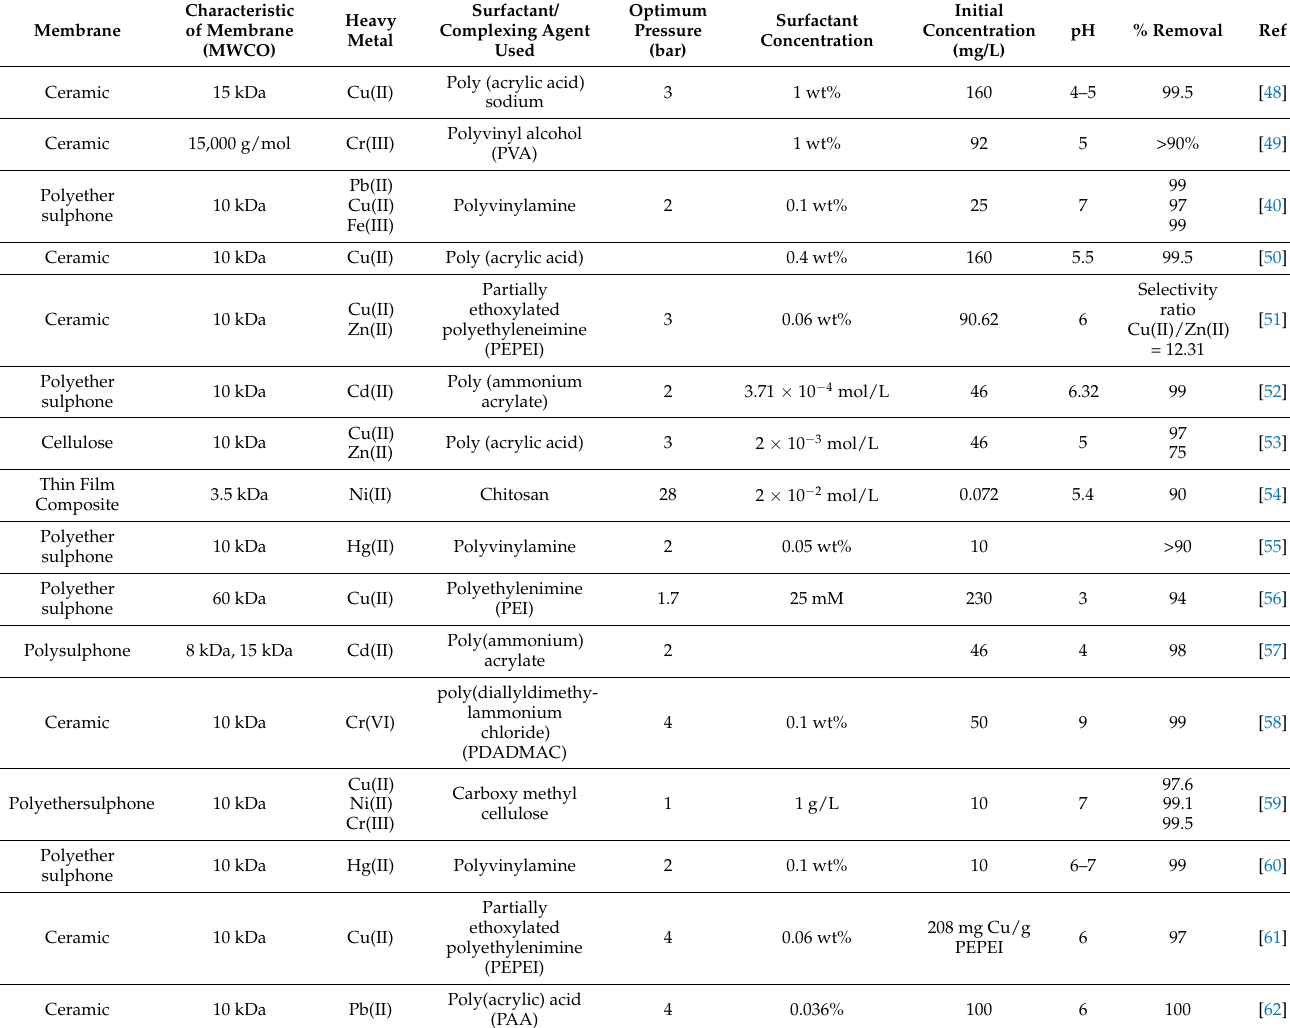
Table 2. Effect of environmental chemistry on the removal of heavy metals by